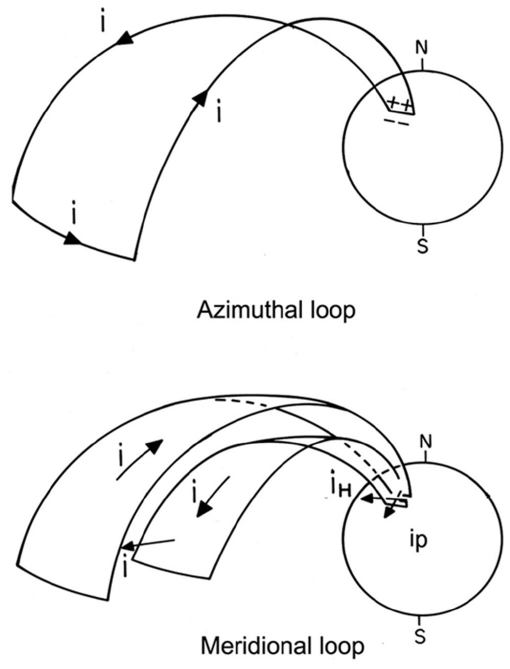
Fig. 10. Bostrom’s azimuthal and meridional current loops (Bostrom, 1964).